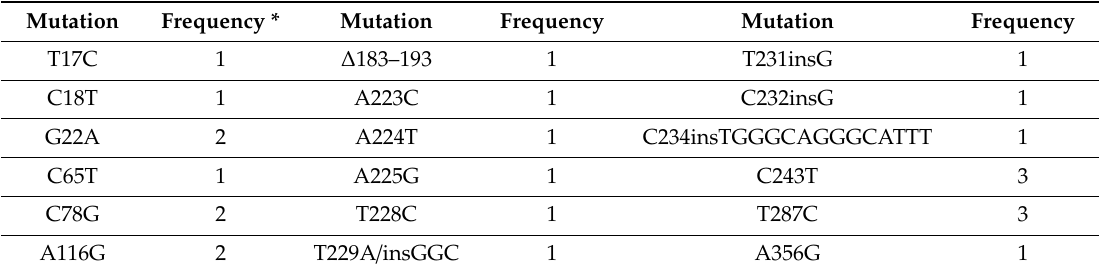
Table 7. Frequency of mutations in the noncoding control region of HPyV6.